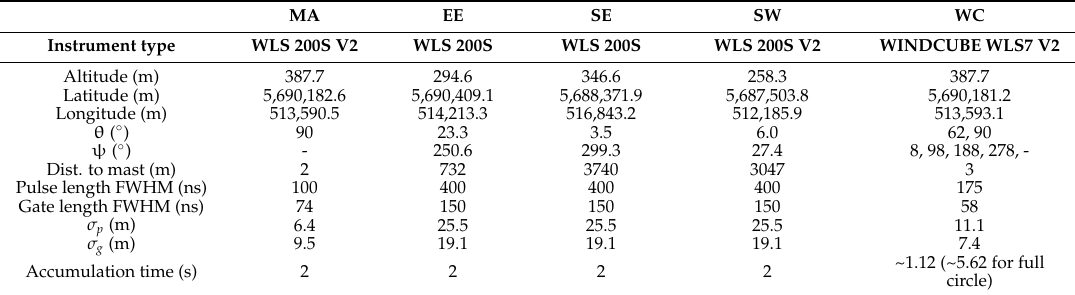
Table 1. Overview of the lidar devices and locations which were used in this study. Coordinates are given in UTM Zone 32U. Pulse length and gate length are given as full width at half maximum (FWHM). MA EE SE SW